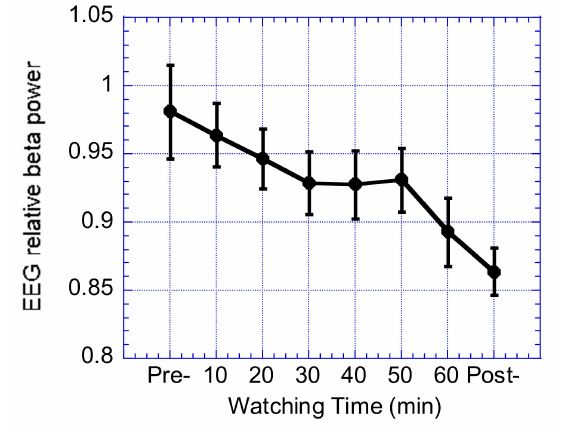
Figure 3. Effect of viewing time on relative β power